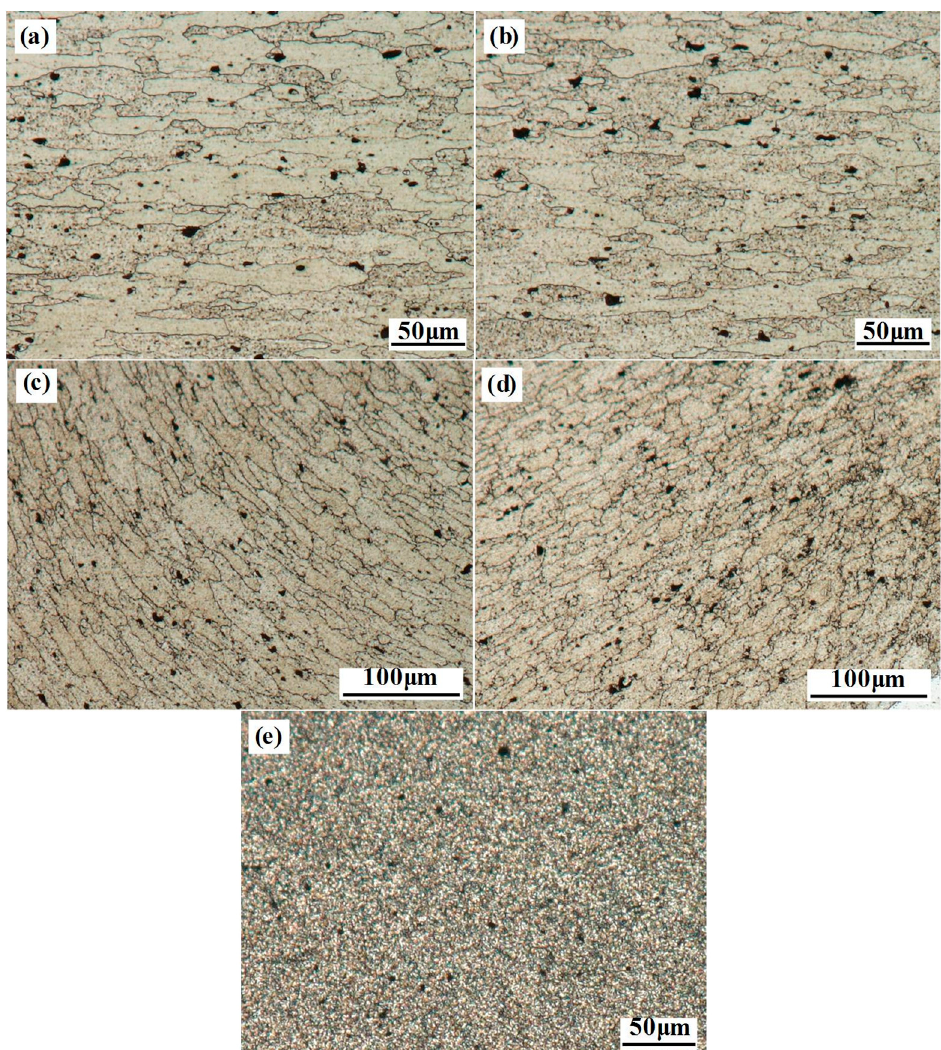
Figure 4. Microstructures extracted from different zones of the FSLW joint welded at 50 mm/min: ( a ) base metal (BM); ( b ) heat affected zone (HAZ); ( c ) thermo-mechanically affected zone (TMAZ) at AS; ( d ) TMAZ at RS; ( e ) weld nugget zone (WNZ).